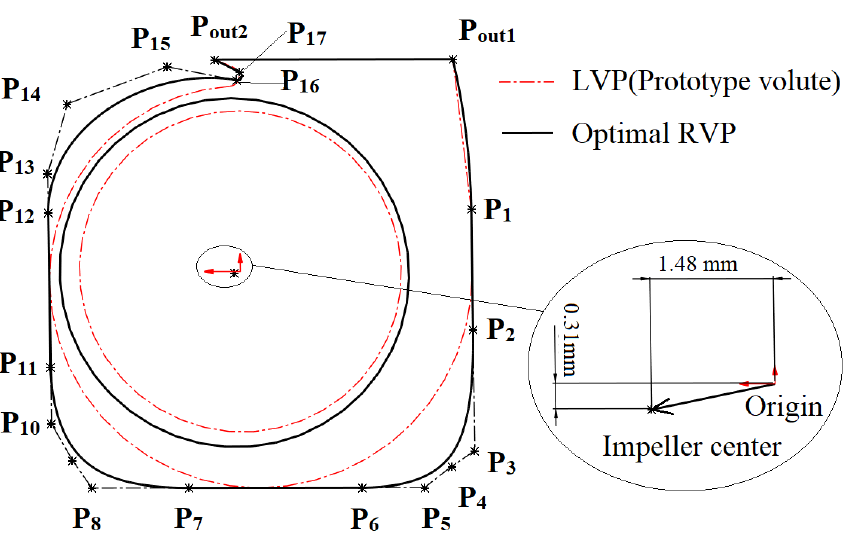
Figure 19. Prototype and optimal volute profile with its control points. Table 5. Coordinates of each control point in the optimal volute